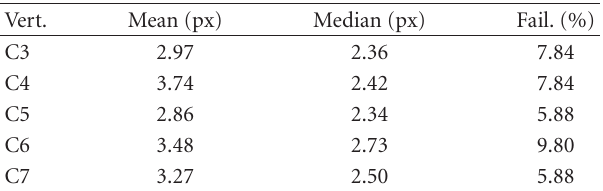
Table 2: Statistical results on the error segmentation: local vertebra model (automated